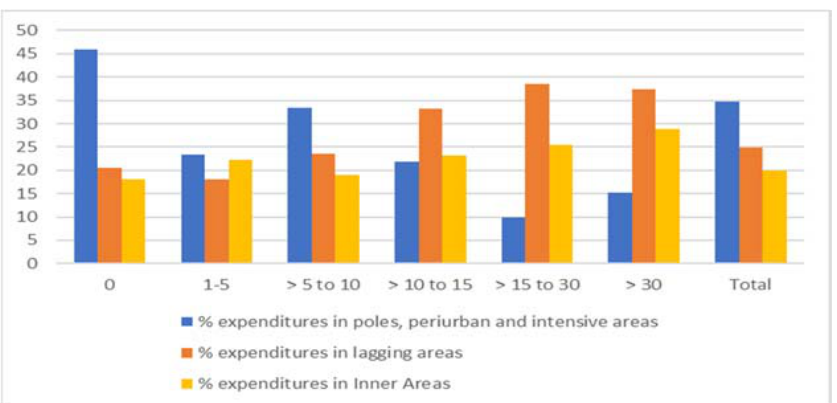
Figure 12. “Mitigated competition tenders”: committed expenditures among different areas by range of scores to lagging areas. Source: authors’ elaborations from the data base of funded investment